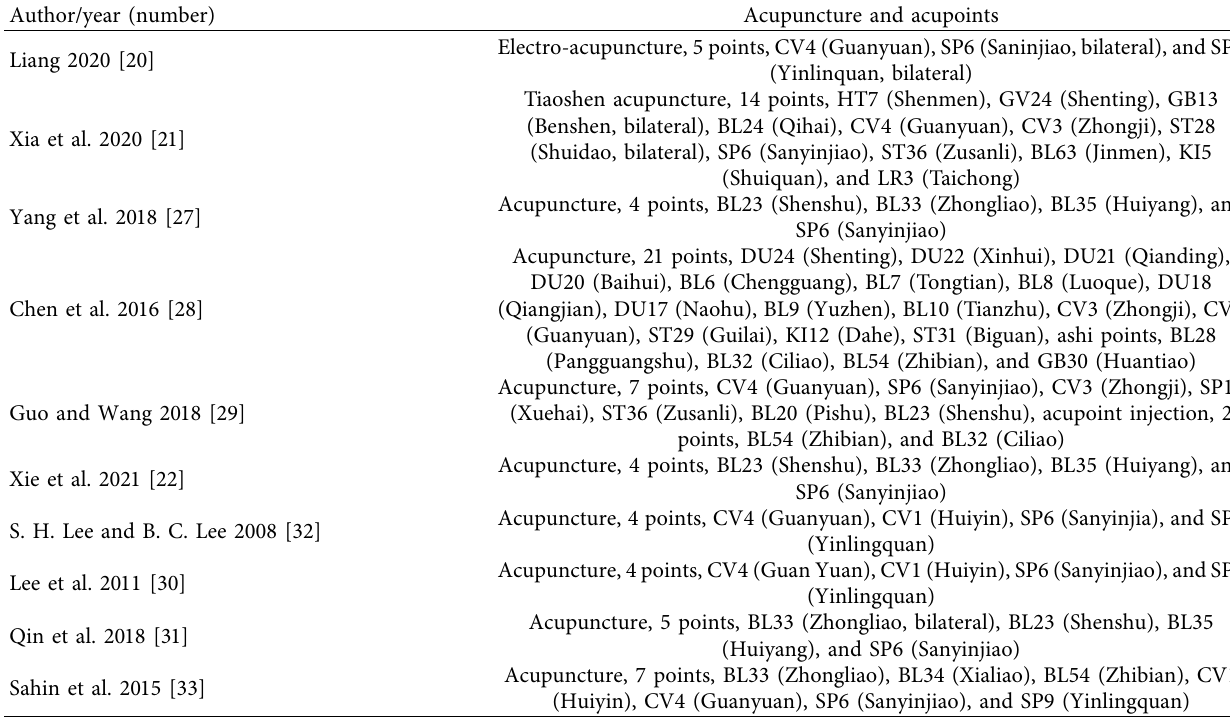
Table 2: Te methods of acupuncture and chosen acupoints of the enrolled